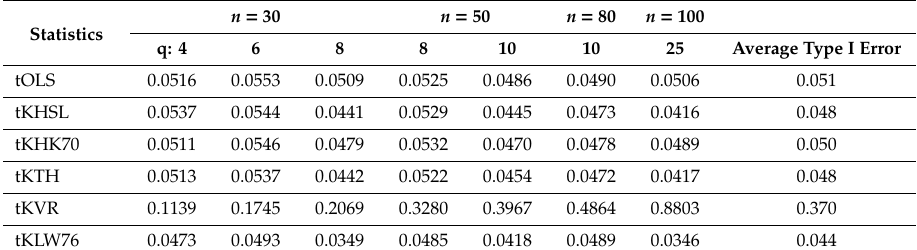
Table 2. Simulated Type I errors for ρ = 0.80 and α =